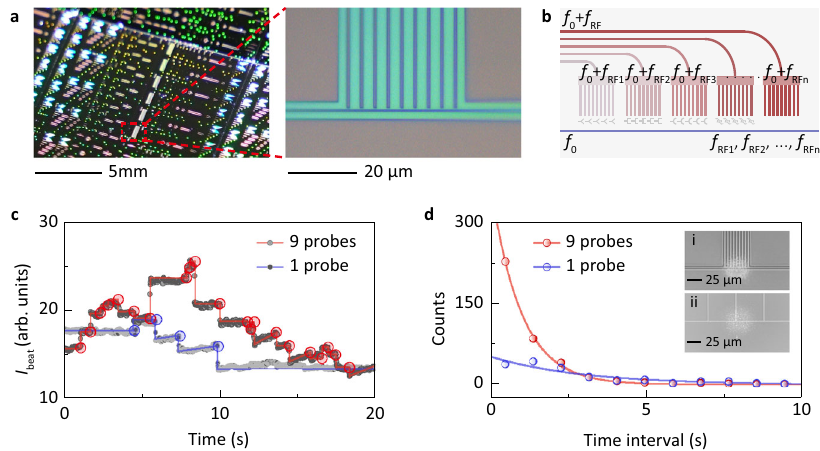
Fig. 5 Waveguide array on a chip for rapid and multiplexed sensing. a Optical images of the waveguide sensor on a chip. b Proposed scheme for the radio-frequency multiplexing. c Beat intensity I beat when single polystyrene nanobeads are deposited onto the sensing area of nine (red curve) and one (blue curve) probe-waveguide con fi gurations, respectively. d Statistical distributions of time intervals between two sequential nanobead-binding events fi tted by the exponential curve. Insets, nine (i) and one (ii) probe-waveguide con fi gurations after nanoparticle